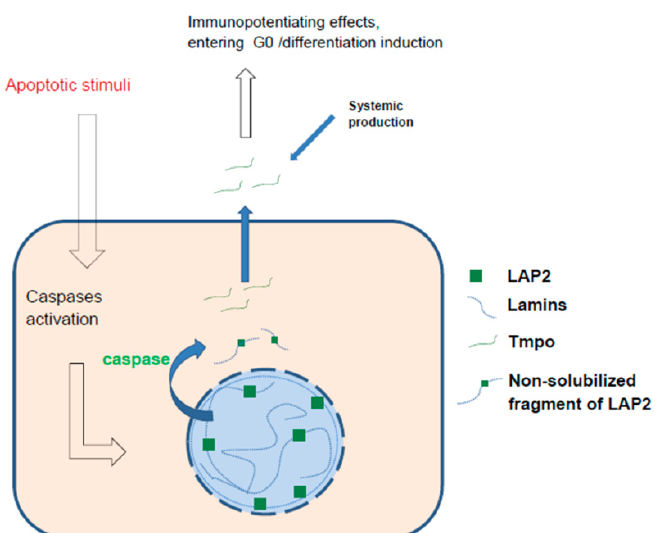
Figure 6. Schematic representation of intracellular and extracellular effects of lamina-associated protein 2 (LAP2) and its fragment thymopoietin (Tmpo). Adapted from our earlier publication [144].